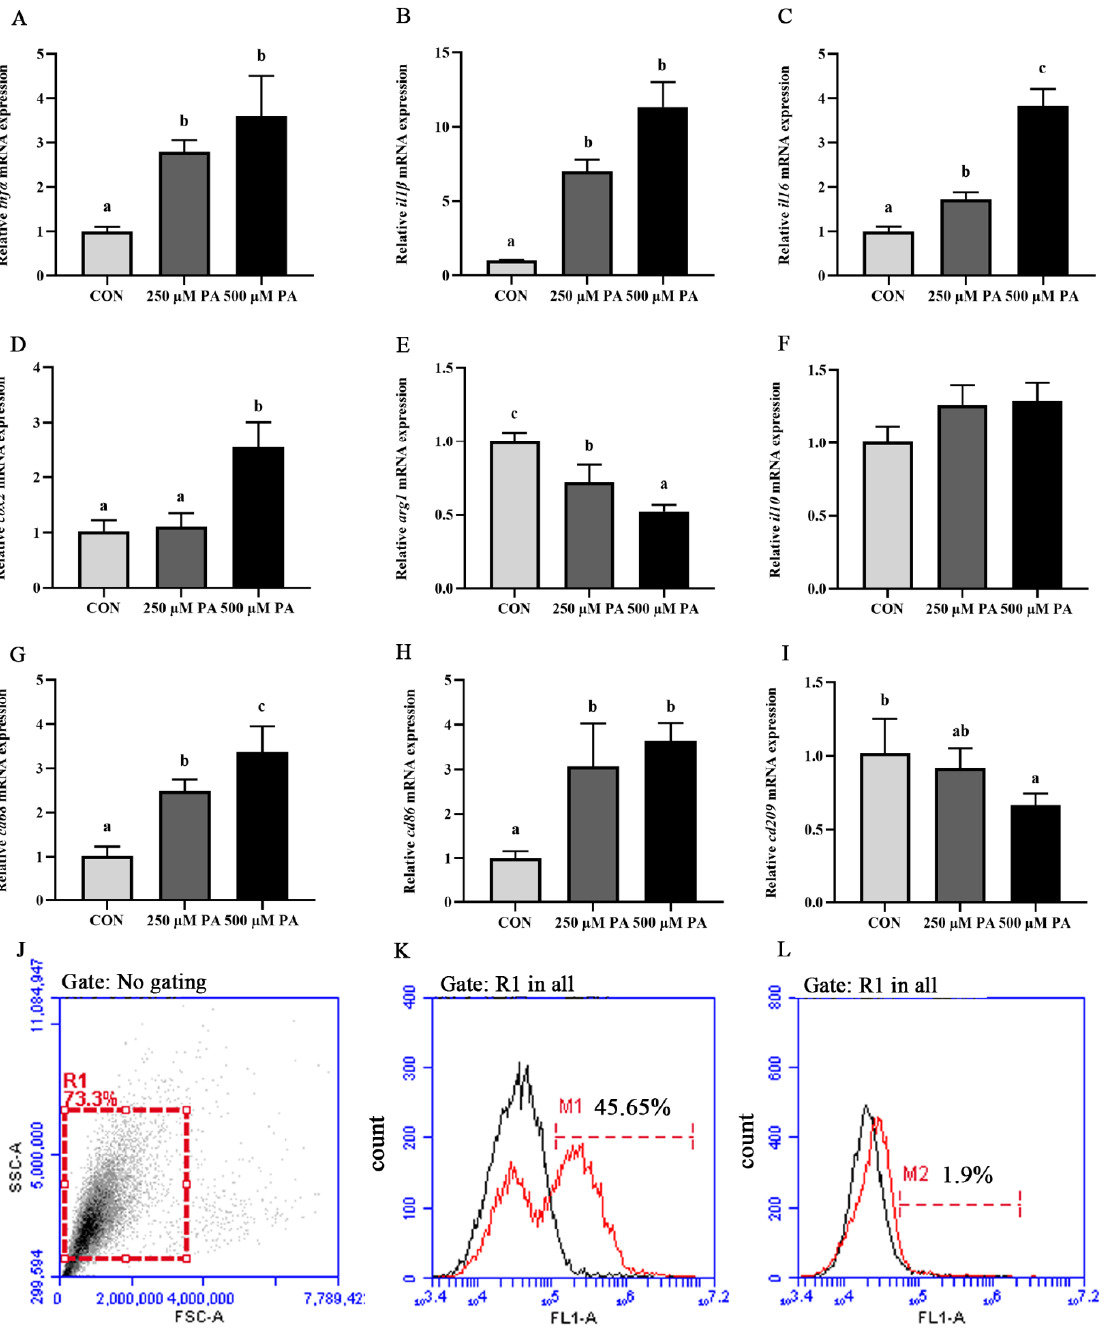
Figure 1. PA induced inflammatory response in macrophages of large yellow croaker. ( A–I ) mRNA expression levels of inflammatory genes ( tnf α , il1 β , il6 , cox2 , arg1 and il10 ) and macrophage markers ( cd68 , cd86 and cd209 ) after PA treatment ( n = 6). ( J–L ) Fluorescence histograms of CD68 + ( K ) and CD209 + ( L ) populations after PA treatment (scale of M1). Represent macrophages gated (R1) on a forward scatter (FSC) versus side scatter (SSC) dot plot. Data are presented as the means ± SEM and are analyzed using one-way ANOVA, followed by Tukey’s test. Bars labeled with the same letters are not significantly different ( p > 0.05).